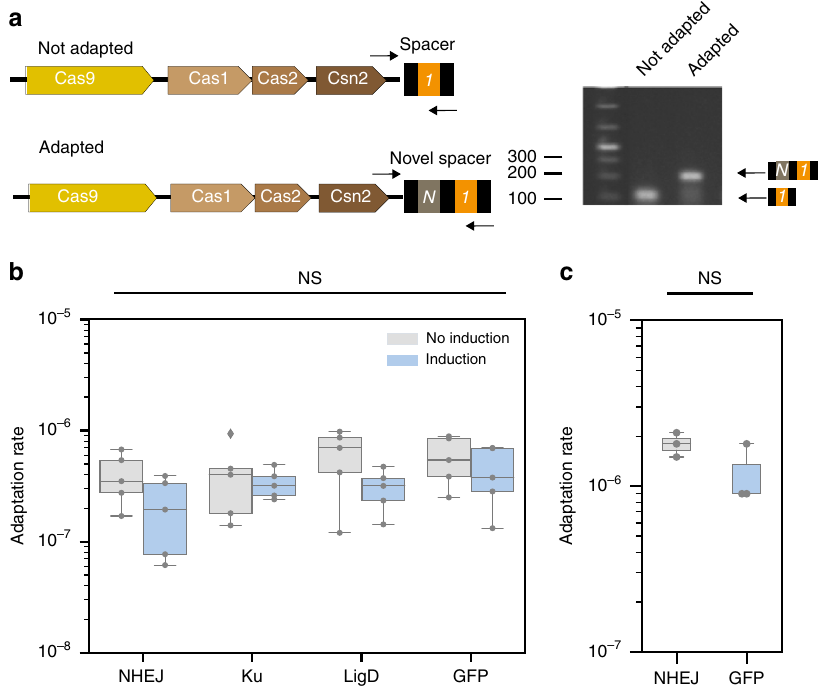
Fig. 3 The B. subtilis NHEJ system has no measurable effect on spacer acquisition. a S. aureus strain RN4220 carrying the type II-A CRISPR-Cas system on plasmid pRH87 was challenged with phage phiNM4. Spacer acquisition was assessed by PCR on isolated colonies that survived the infection (oligonucleotides are depicted as black arrows). b Adaptation rate measured in the presence of NHEJ, ku, ligD, or GFP carried by plasmids pAB23, pAB24, pAB25, and pAB62, respectively ( n = 5, ANOVA, NS P = 0.5674). c Adaptation rate of S. thermophilus DGCC7710 against phage Phi2972 when expressing the B. subtilis NHEJ system from plasmid pAB66 or a control GFP from plasmid pAB69 ( n = 3, two-sided t test, NS P =